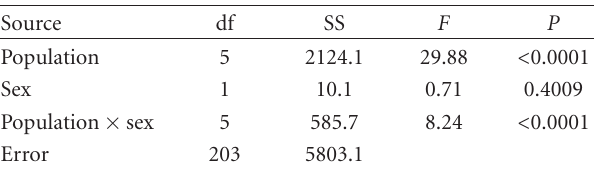
Table 2: ANOVA: sources of variation in relative host plant pref- erence of individual B. treatae assessed from no-choice preference